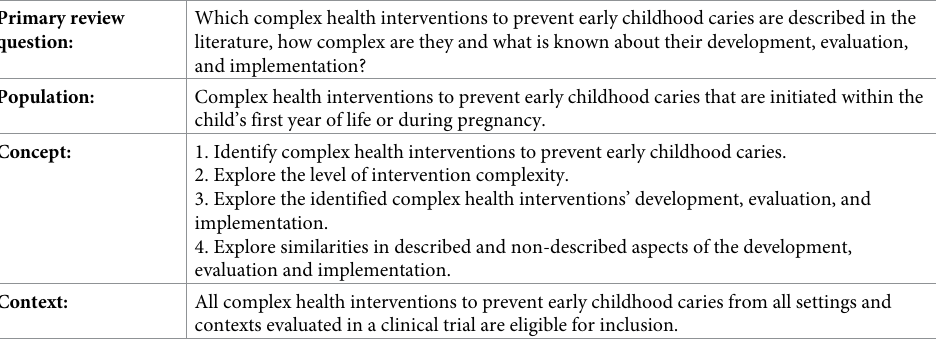
Table 1. Identifying the main concepts and primary review question using the population-concept-context framework. Primary review